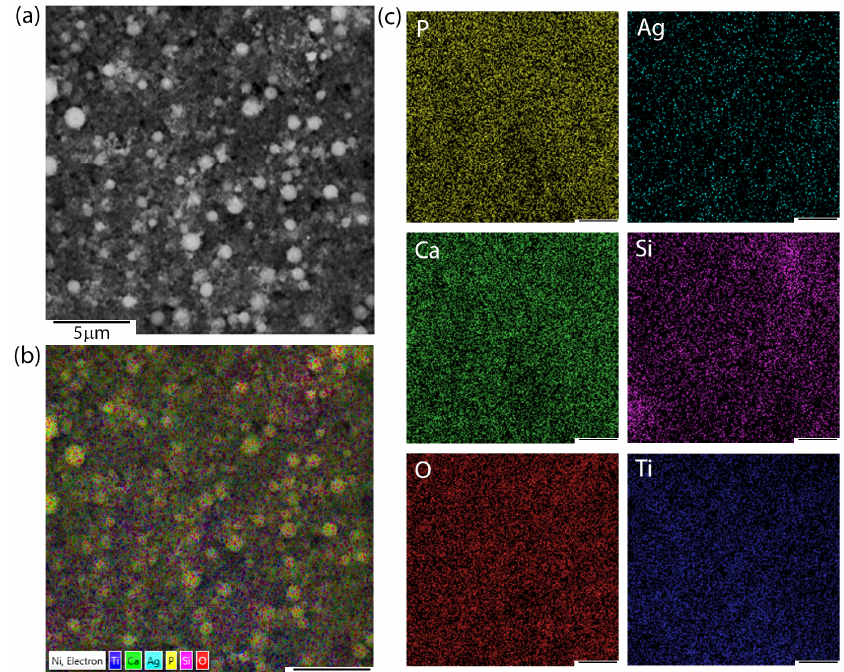
Figure 6. SEM image of the 5:1 coating ( a ), multi-layer elemental distribution ( b ) and chemical composition imaging of elements ( c ) after heat treatment.